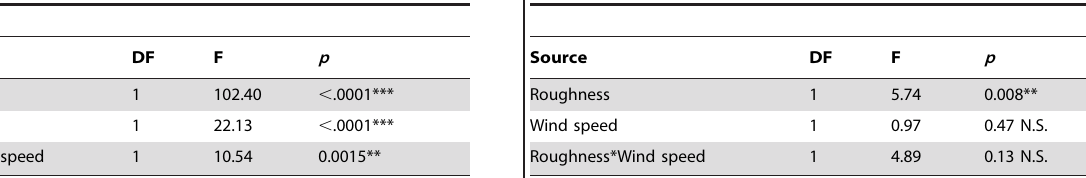
Table 1. Effects of larval behavior and wind speed on distance traveled by C. dorsalis media larvae.